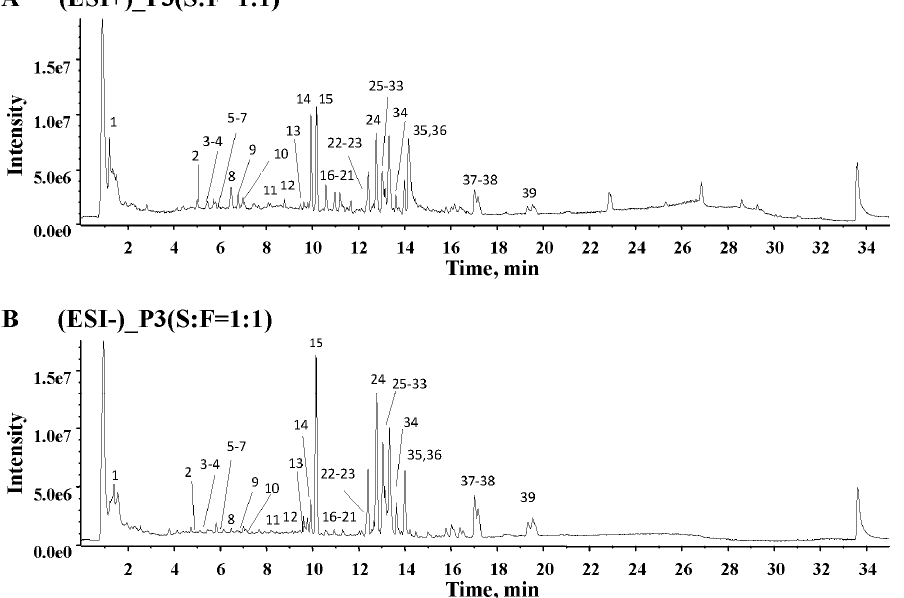
Figure 2. Representative total ion chromatograms of the ShenFu Prescription Decoction (SFPD) by UPLC-QTOF-MS. ( A ) Total ion chromatograms (TIC) of P3 in positive ion mode; ( B ) TIC of P3 in negative ion mode.